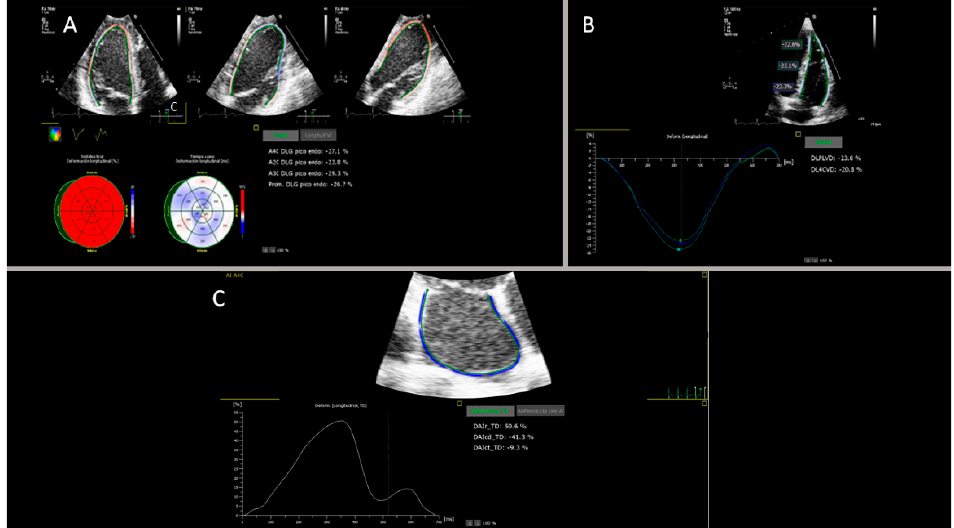
Figure 1. Panel ( A ): Output of the left ventricular longitudinal strain analyses. The upper part shows, from left to right, the endocardial tracking of chambers four, two and three; the bottom left part shows the bull’s eye with the strain values (%) and the time to peak longitudinal strain (ms) for the 18 segments. On the bottom right part, the LVGLS results for chambers four, two and three and the average LVGLS (%) can be found. Panel ( B ): Output of the right ventricular longitudinal strain analyses. The upper part shows the endocardial tracing in the four apical chambers: basal, medial, apical and RVFWLS: (%). The bottom left part shows the deformation curves versus the time for each segment (coloured curves). On the right, the results of the average RVFWLS and the average RV4CLS (%) are found. Panel ( C ): Output of the left atrium longitudinal strain analyses. At the top is the apical four-chamber endocardial tracing; at the bottom left is the strain versus time curve, and at the bottom right, the GLS results for each of the phases of the atrium (reservoir, conduit and contraction) (%) can be found.